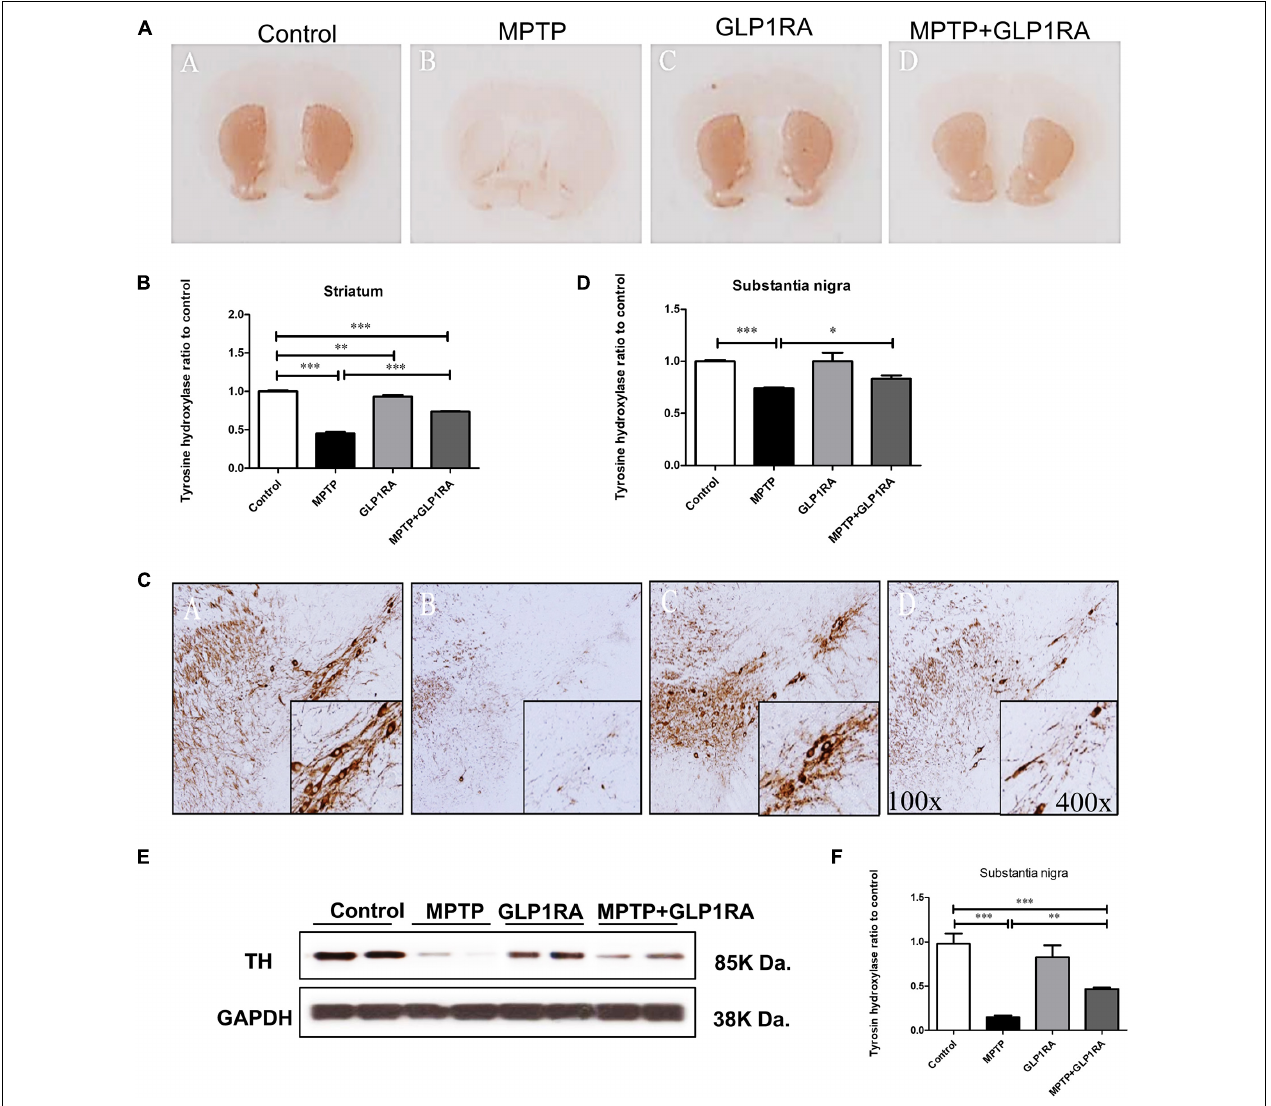
FIGURE 3 | The GLP-1RA (liraglutide) protects dopaminergic neuron from MPTP-induced cell death. Immunohistochemistry (IHC) staining and immunoblotting of tyrosine hydroxylase (TH) in the striatum and substantia nigra were performed for the evaluation of viability of dopaminergic neurons. Mice were treated according to the four groups, control/MPTP/GLP-1RA/MPTP + GLP-1RA, and sacrificed on the 3rd day. (A,B) TH-IHC-stained striatum sections of the four groups (left to right: the control, MPTP, GLP-1RA, and MPTP + GLP-1RA groups) were viewed via a 4x light microscope and presented as TH staining intensity to percentage of the control, quantified using ImageJ software. n = 3 per group. (C,D) TH-IHC-stained substantia nigra sections of the four groups (left to right: the control, MPTP, GLP-1RA, and MPTP + GLP-1RA groups) were viewed via a 400x light microscope and presented as TH staining intensity to percentage of the control, quantified using ImageJ software. MPTP greatly reduced TH staining in comparison to control while the GLP-1RA partially reversed this. n = 3 per group. (E,F) Representative gels on immunoblotting of TH in the substantia nigra sections of the four groups. Protein expressions were normalized to GADPH as an internal standard, quantified using ImageJ software. Data are expressed as optical density to control. n = 4 per group. The values represent mean ± SD (one-way ANOVA, * P < 0.05, ** p < 0.01, *** P < 0.001). GLP-1RA, glucagon-like peptide-1 receptor